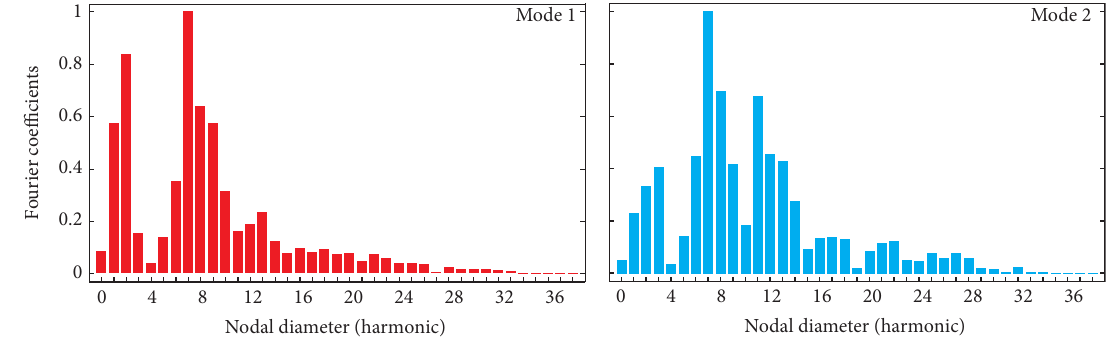
Figure 13: Distribution of the Fourier coefficients of the spatial decomposition of the two modes closer to 𝑛 = 7 diameters.